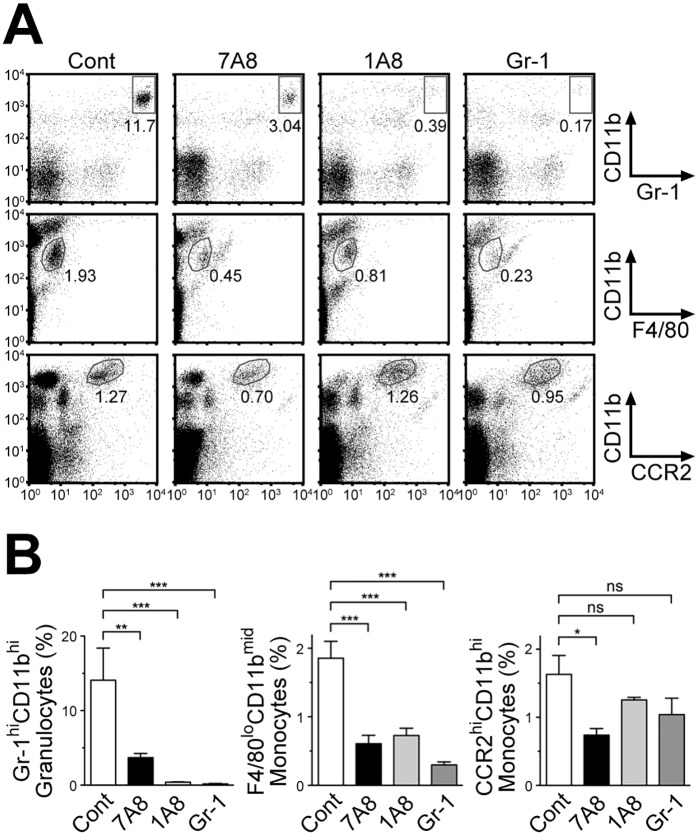
The 7A8 mAb depletes granulocytes and monocytes in vivo.(A, B) WT mice were injected intraperitoneally with 7A8, 1A8, anti-Gr-1 mAbs, or PBS as a control. (A) PBL were collected at 1 day after mAb injection and stained with 7A8, anti-Gr-1, anti-F4/80, and anti-CCR2 mAbs. The staining was analyzed separately in Gr-1 and CD11b (upper panels), F4/80 and CD11b (middle panels), or CCR2 and CD11b (lower panels). (B) The percentages of Gr-1hiCD11bhi(CCR2-F4/80-) granulocytes (left panel), F4/80loCD11bmid(CCR2loGr-1mid) monocytes (middle panel), and CCR2hiCD11bhi(F4/80loGr-1hi) monocytes (right panel) within total PBL (n = 4–5) are shown. Cont: control. Data were analyzed by one-way ANOVA, followed by the Bonferroni post-hoc test. ns, not significant. *, p < 0.05; **, p < 0.01; ***, p < 0.001.